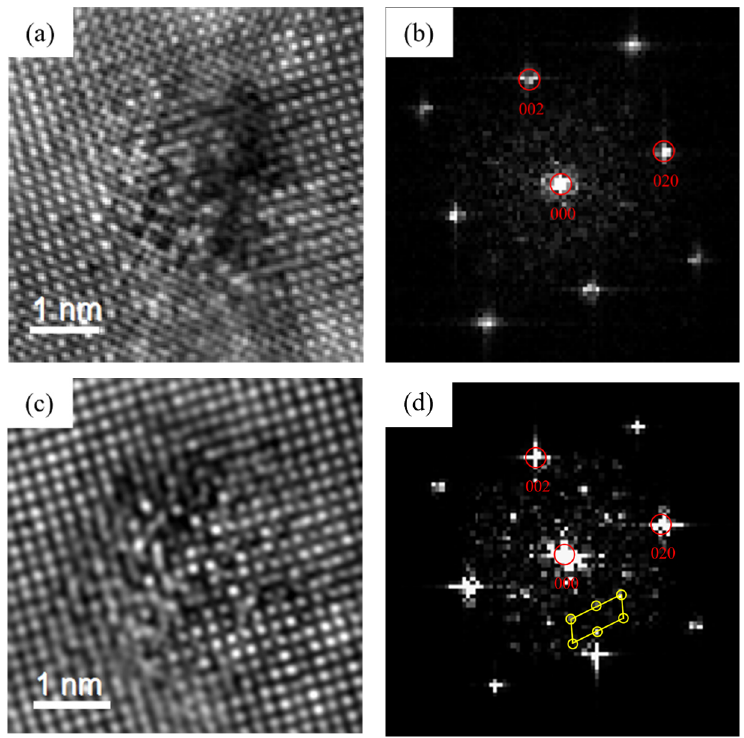
Figure 7. HRTEM and FFT pa tt erns of precipitates of 0.37Cu alloy after initial aging at 175 °C for 0.5 h. ( a , b ) GP zones; ( c , d ) pre- β″ .